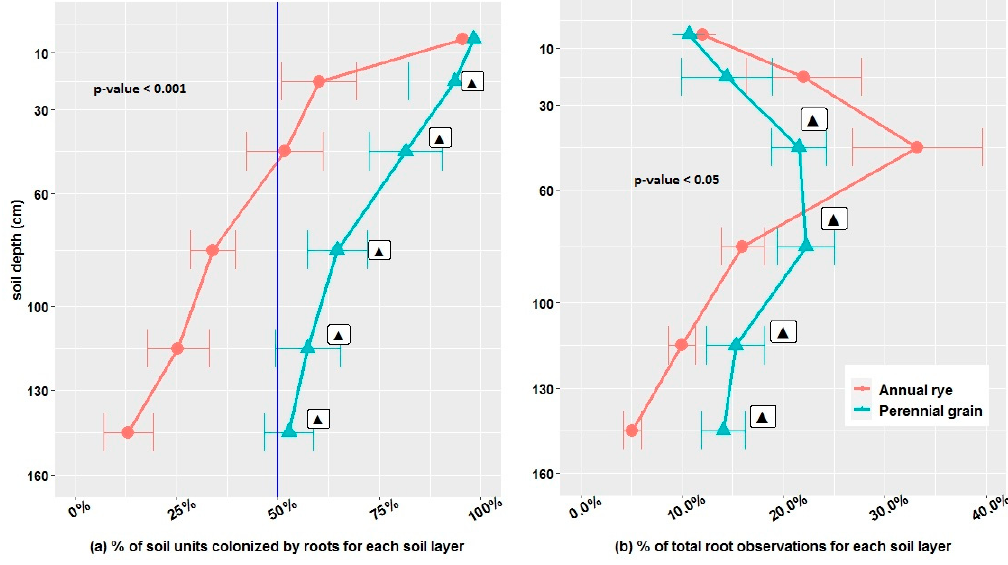
Figure 3. Mean root colonization of the soil profile observed at the second crop season, under intermediate wheatgrass and annual winter rye. Standard errors are represented by error bars. Statistical differences (post hoc analyses) between annual and perennial grains are indicated by ▲ .